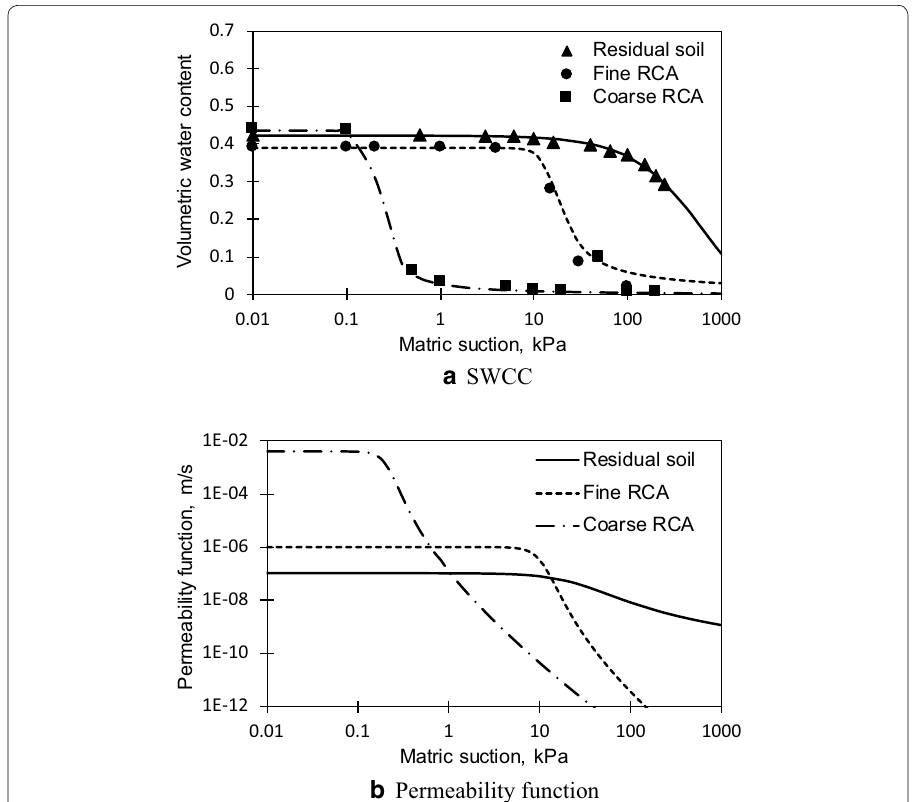
Fig. 11 Hydraulic properties of residual soil, FRCA and CRCA